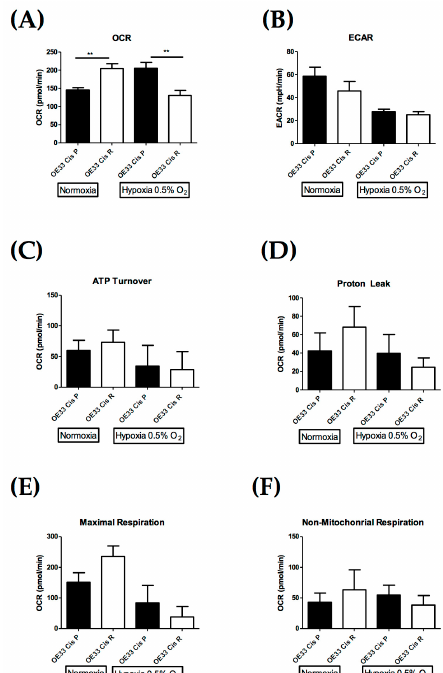
Figure 5. Cisplatin-resistant (OE33 Cis R) oesophageal adenocarcinoma cells have an altered metabolic phenotype compared to cisplatin-sensitive (OE33 Cis P) cells under normoxic and hypoxic conditions (0.5% O 2 ). ( A ) The oxygen consumption rate (OCR), which is a measure of oxidative phosphorylation, was evaluated in OE33 Cis P and OE33 Cis R OAC cells using the Seahorse Biosciences XFe24 extracellular flux analyser cultured under normoxic and hypoxic conditions (0.5% O 2 ). OE33 Cis R cells have a significantly higher OCR when compared to OE33 Cis P; cisplatin-sensitive cells, under normoxic conditions (n = 5), unpaired t -test, ** p < 0.01. ( B ) The extracellular acidification rate